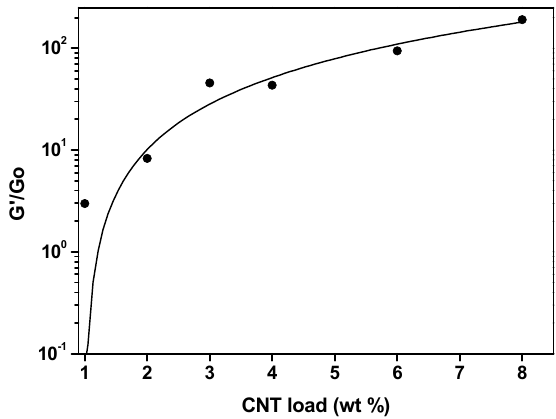
Figure 5. Normalized storage modulus at T = 180 °C as a function of MWCNT concentration fitted to the equation of the statistical percolation theory (see